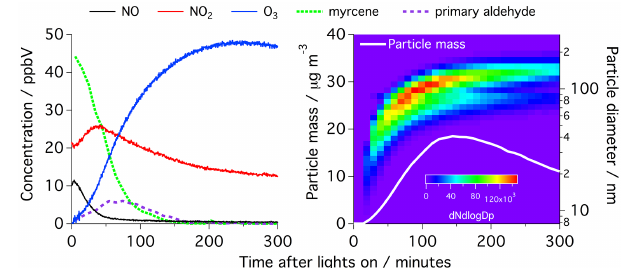
Figure 1. (a) NO x , O 3 , myrcene and 4-vinyl-4-pentenal (primary aldehyde product), and (b) particle mass (not wall loss corrected and assuming ρ = 1 . 3) and size evolution within the MAC during a typical photooxidation